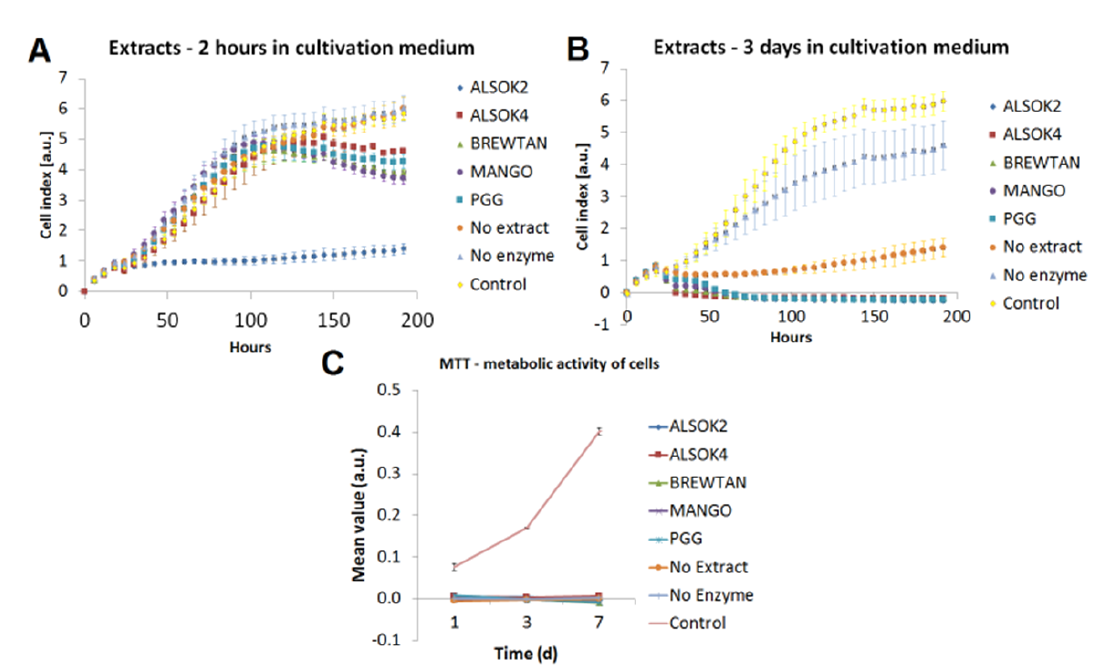
Figure 5. Cell biological and antibacterial testing. ( A ) Growth of Saos-2 cells in eluate from mineralized hydrogels containing di ff erent gallotannin preparations incubated for 2 h in cell culture medium. Tissue culture plastic served as a control. ( B ) Growth of Saos-2 cells in eluate from mineralized hydrogels containing di ff erent gallotannin preparations incubated for 3 d in cell culture medium. Tissue culture plastic served as a control. ( C ) Growth of Saos-2 cells on mineralized hydrogels containing di ff erent gallotannin preparations. Tissue culture plastic served as a